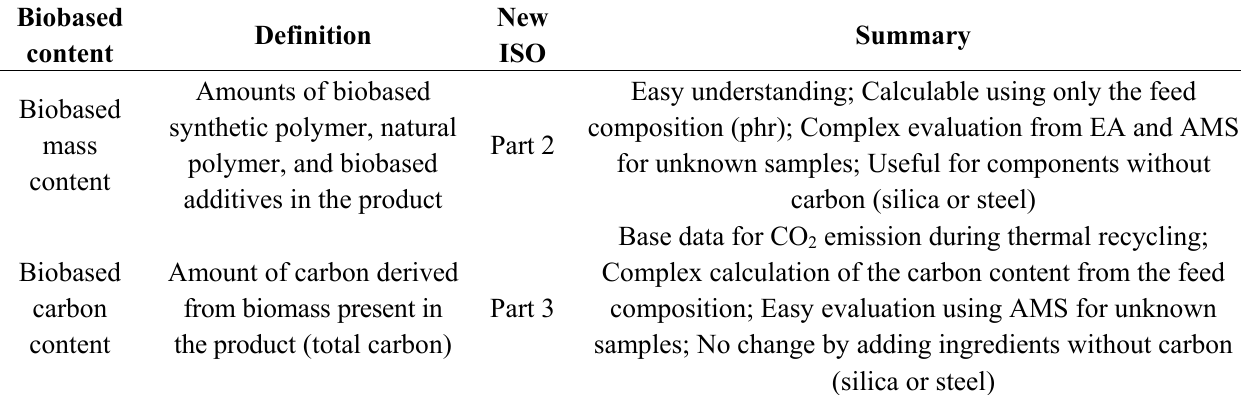
Table 13. Biobased contents based on proposed ISO for rubber